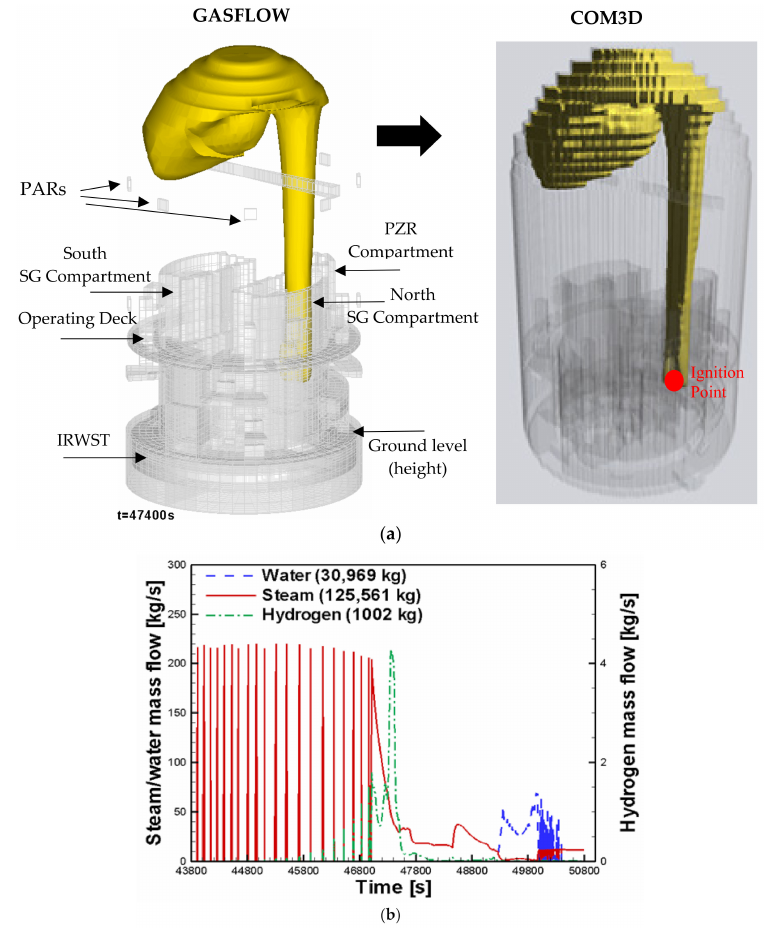
Figure 7. MAAP and GASFLOW results for the SBO accident. ( a ) Iso-surface of H 2 10% in the grid model of CASFLOW and COM3D. ( b ) Predicted hydrogen and steam generation rate by